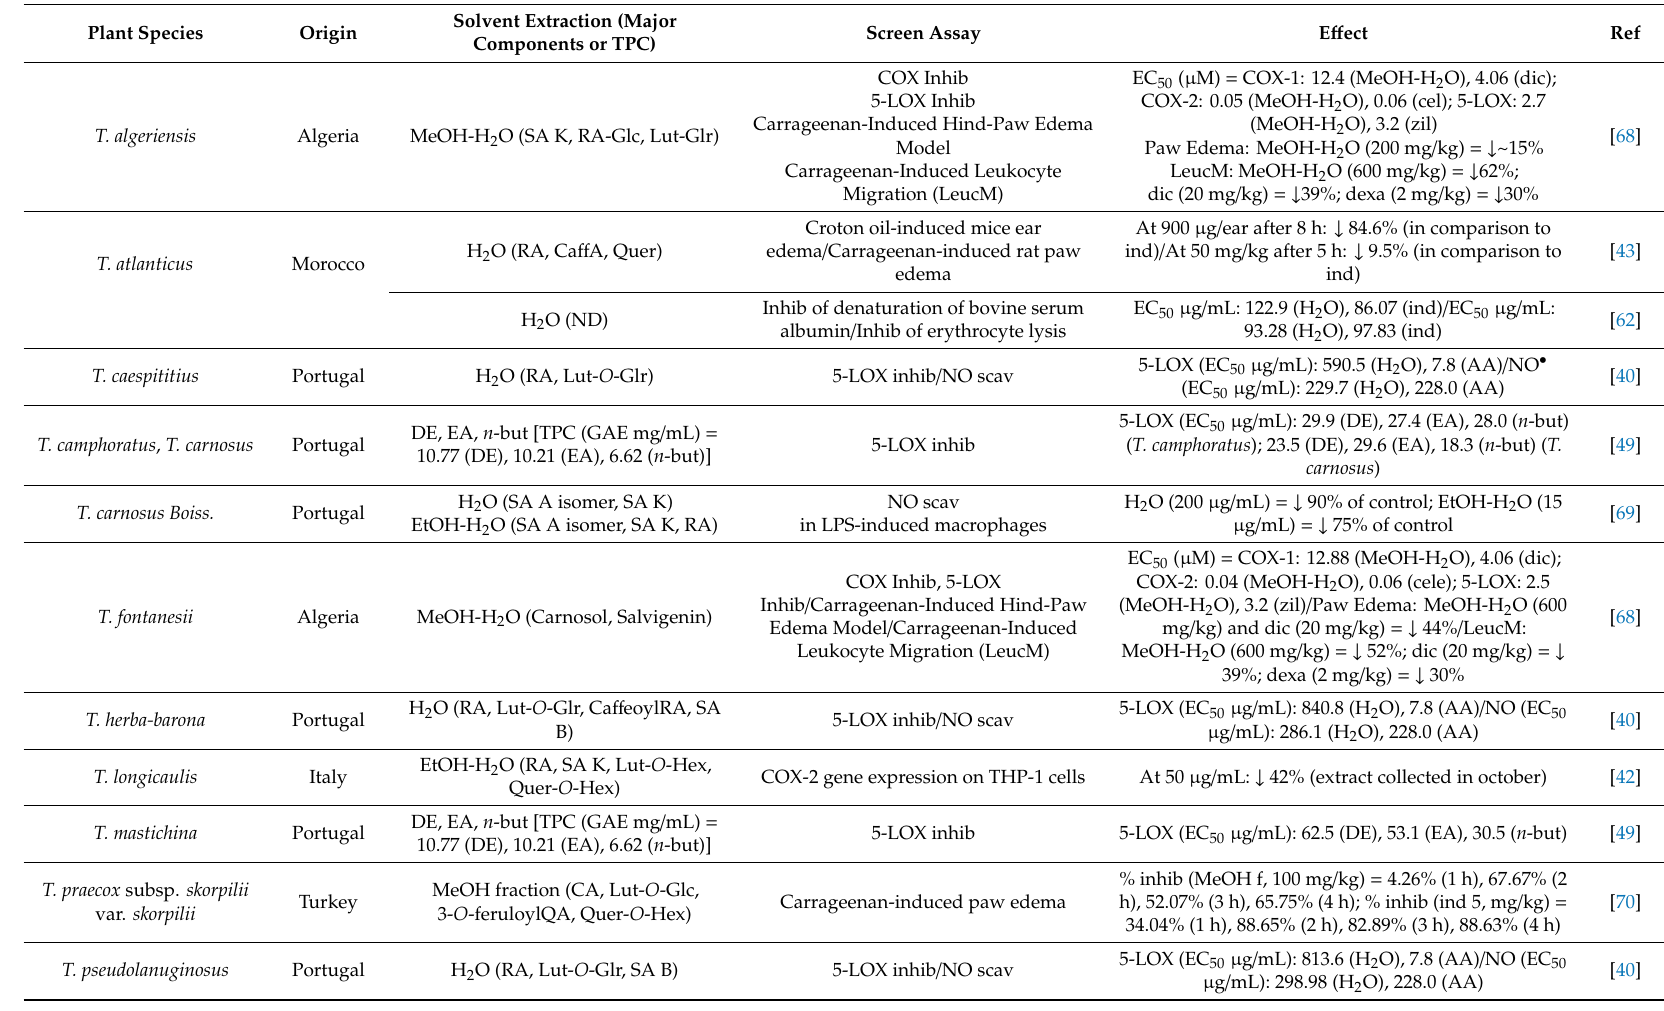
Table 2. Anti-inflammatory properties of phenolic-rich extracts of distinct Thymus